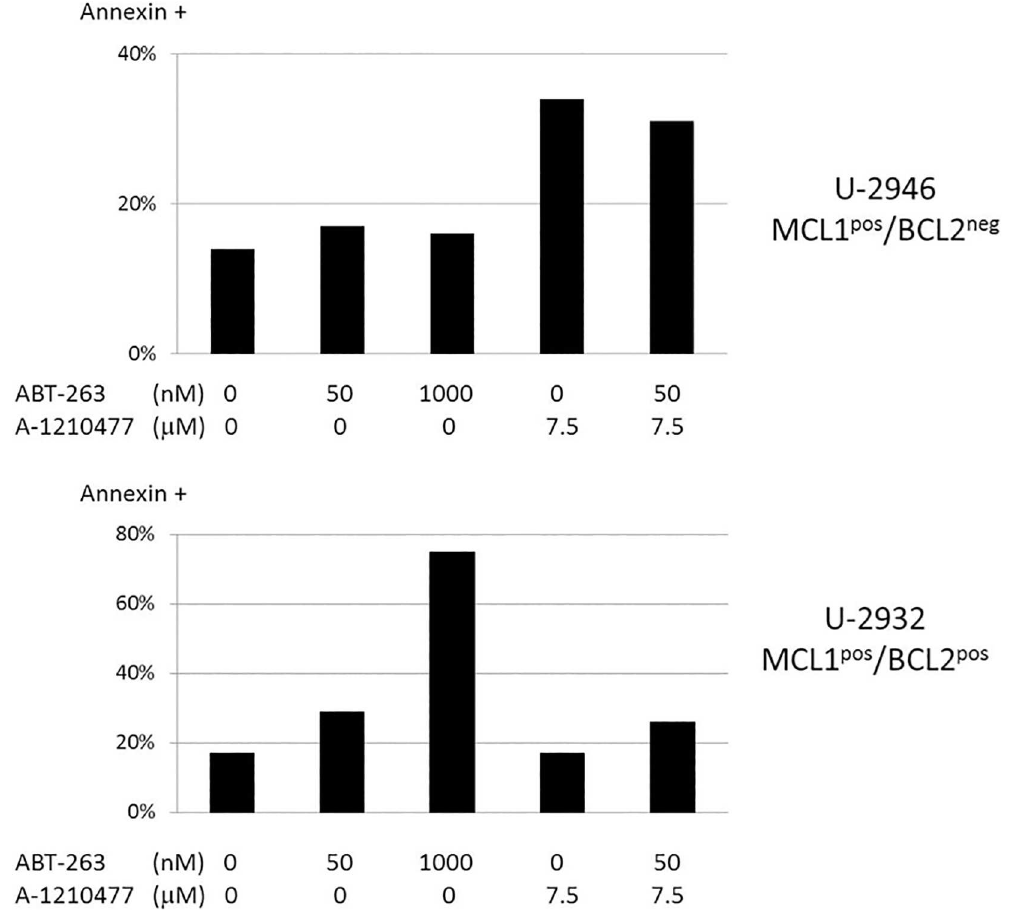
Fig 6. Inhibition of BCL2 and MCL1: effect on apoptosis. Apoptosiswas assessed by Annexin-Vstaining,24 h after additionof a BCL2 inhibitor(ABT-263) or an MCL1 inhibitor(A-1210477).The MCL1 inhibitortriggered apoptosisin the MCL1 pos /BCL2 neg cell line U-2946, BCL2 inhibitioninducedapoptosisin the MCL1 pos /BCL2 pos cell line U-2932.AlthoughexpressingMCL1, cell line U-2932was not responsiveto MCL1 inhibition,suggesting dominant function of BCL2. The data were reproduced in two independent